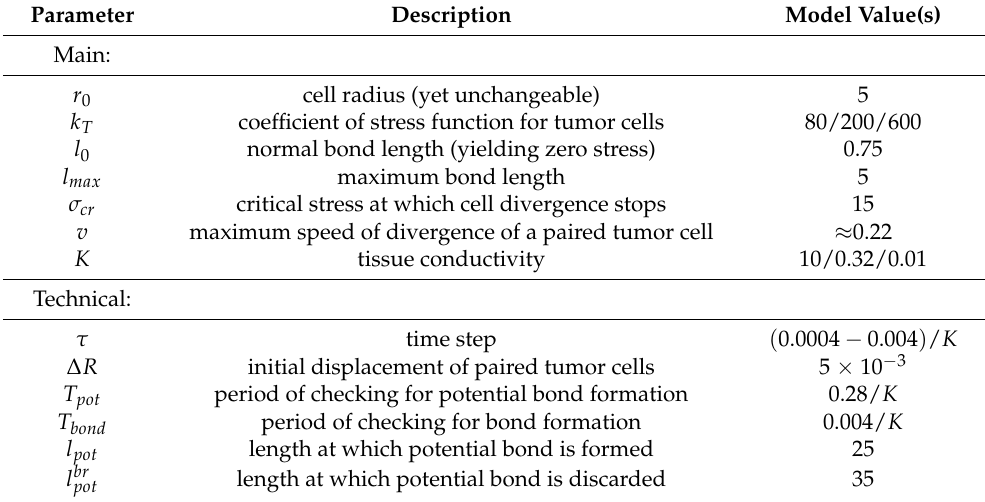
Table 1. Model parameters used during the simulations of free tumor